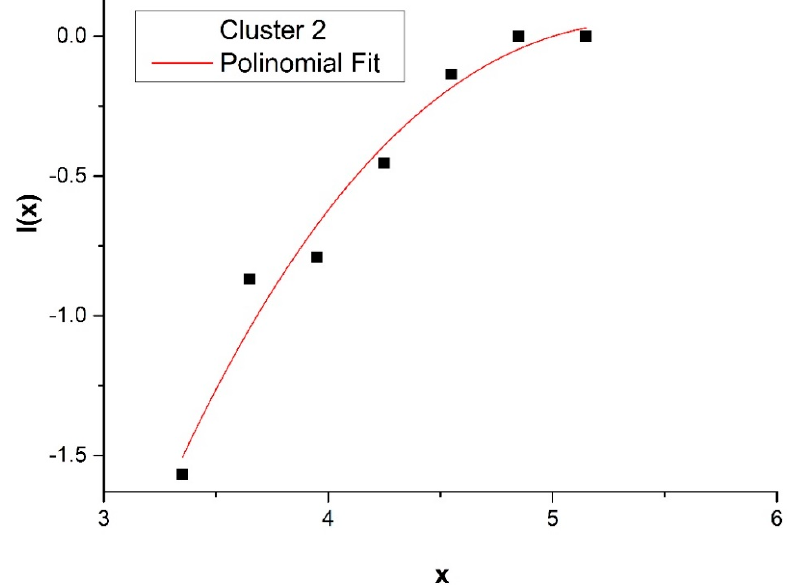
Figure 4. Cumulative distribution I(x) for Cluster 2 fitted using the analytical expression, Equation (1), I(x) = 10 f(x) , where f ( x ) is a polynomial of third degree and x = Log(T T ).